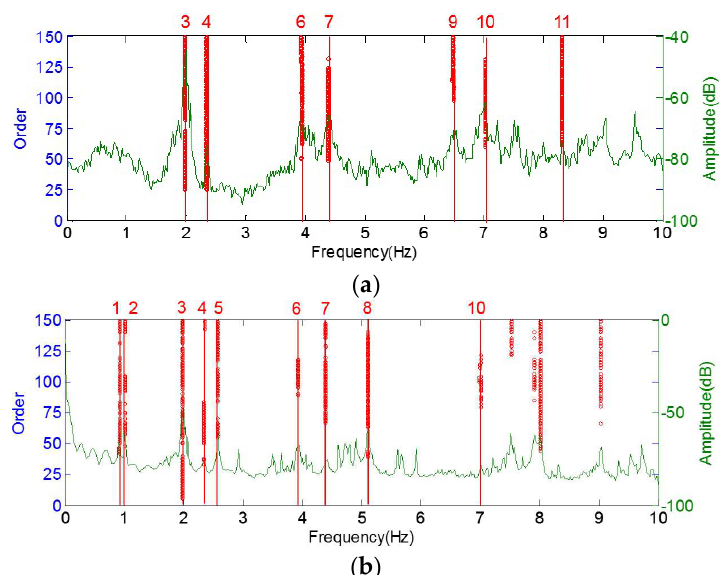
Figure 8. Cleaned stabilization diagram of the deck and the arch using the DBSCAN algorithm: ( a ) stabilization diagram obtained from the acceleration signals in the deck; ( b ) stabilization diagram obtained from the acceleration signals on the arch. Sensors 2019 , 19 , x FOR PEER REVIEW